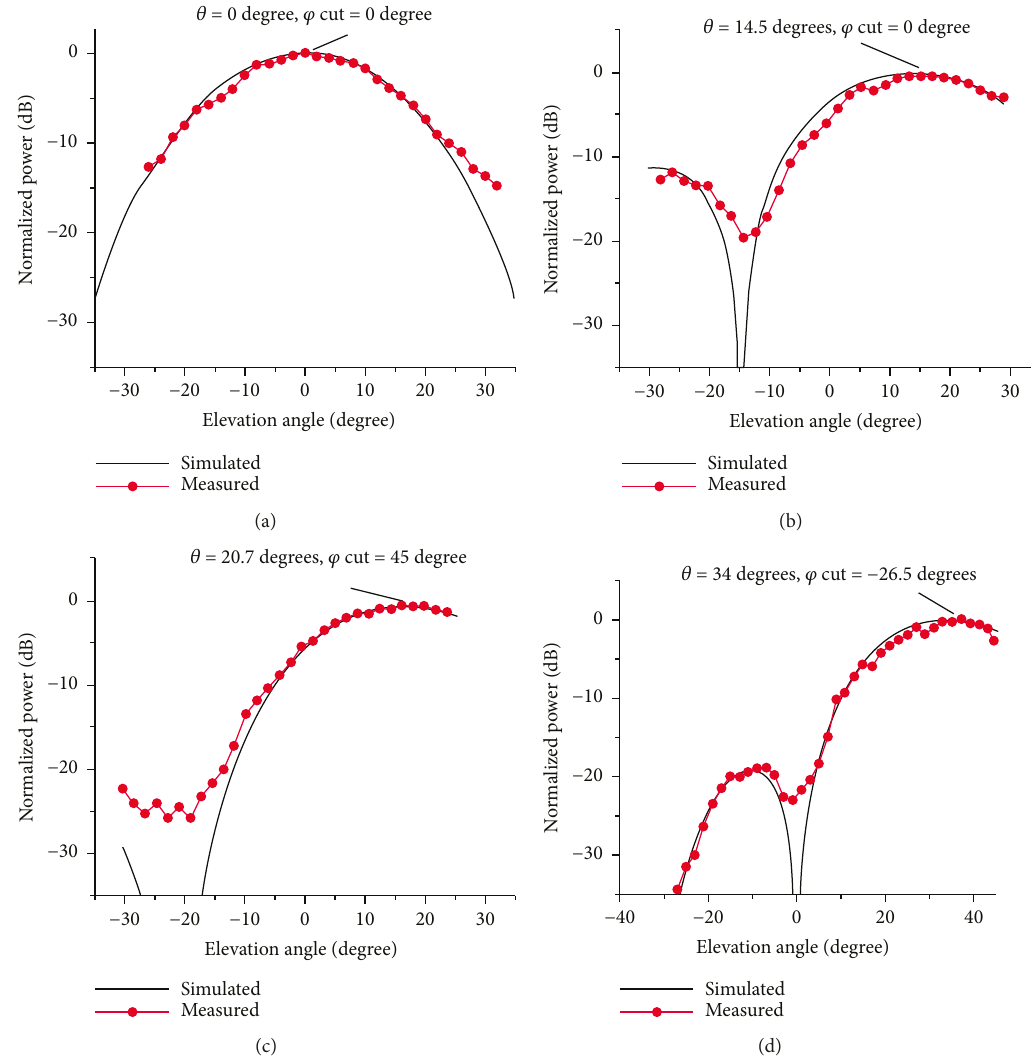
Figure 4: Measured and simulated far- fi eld radiation patterns of the printed PAA system at 5 GHz steering at (a) θ =0, φ =0; (b) θ =14.5, φ =0; (c) θ =20.7, φ = − 45; and (d) θ =34, φ = − 26.5